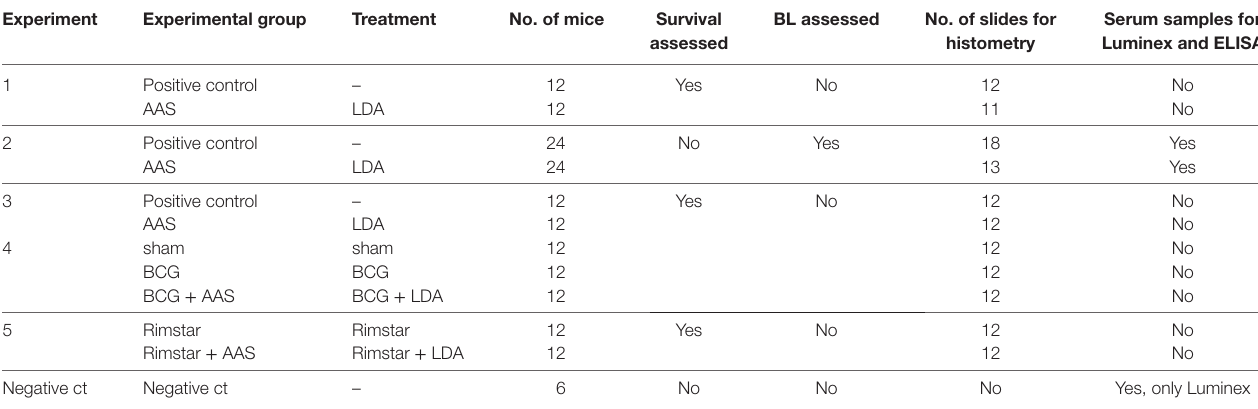
TaBle 2 | Overview of the experiments and methods employed.